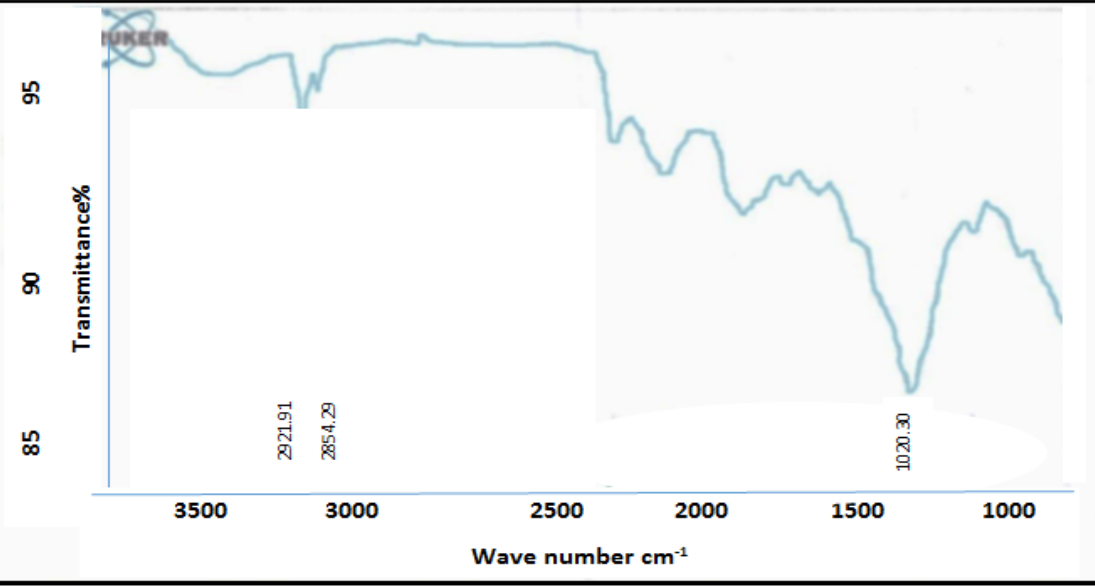
Fig. 7: FTIR spectrum of citrus aurantium